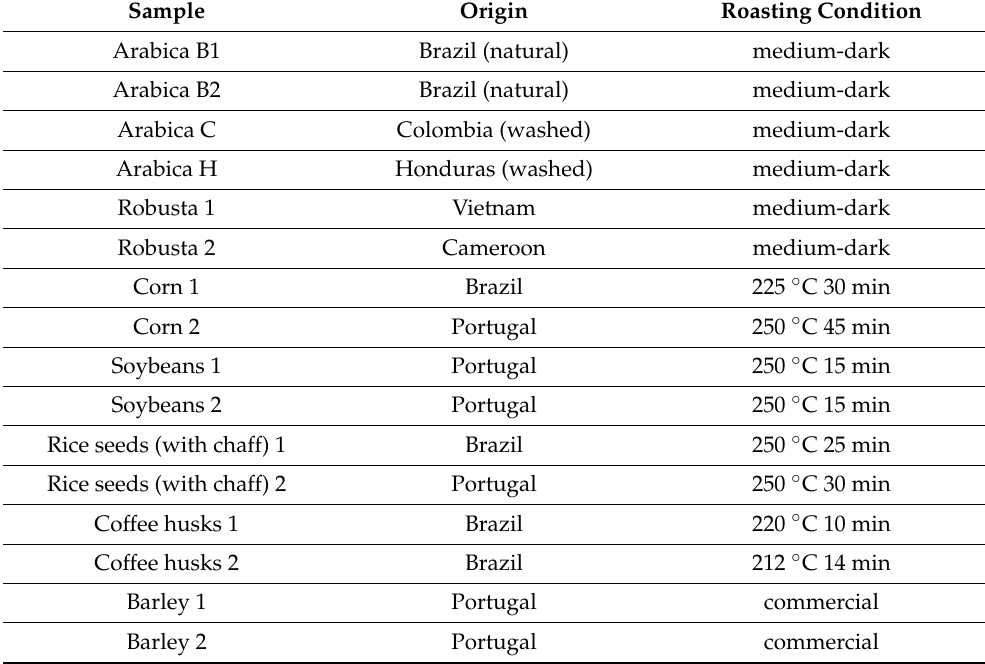
Table 1. List of the coffee samples and adulterants according to origin and degree of